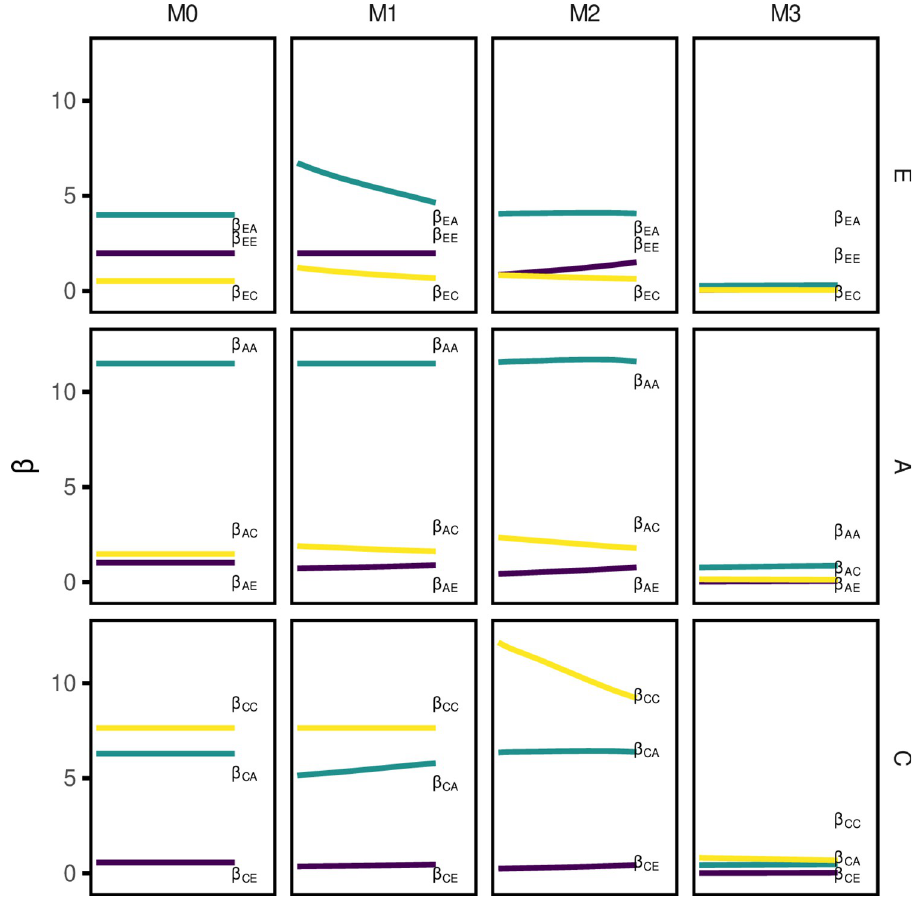
Fig 2. Beta parameter change with time between all age group pairs. Beta represents the effective contact rate between two age groups (subscripts) per six-month time step. Horizontal panels represent the age group making contacts; lines represent the beta parameter values corresponding to the number of contacts with the contactee group. A = adult, C = children, E =